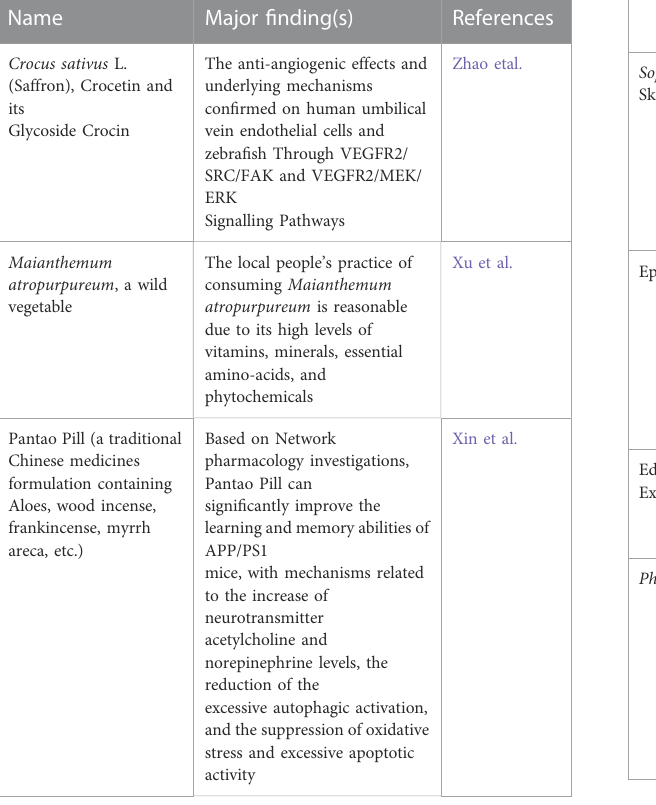
TABLE 1 Edible and medicinal plants and products investigated in the present Research